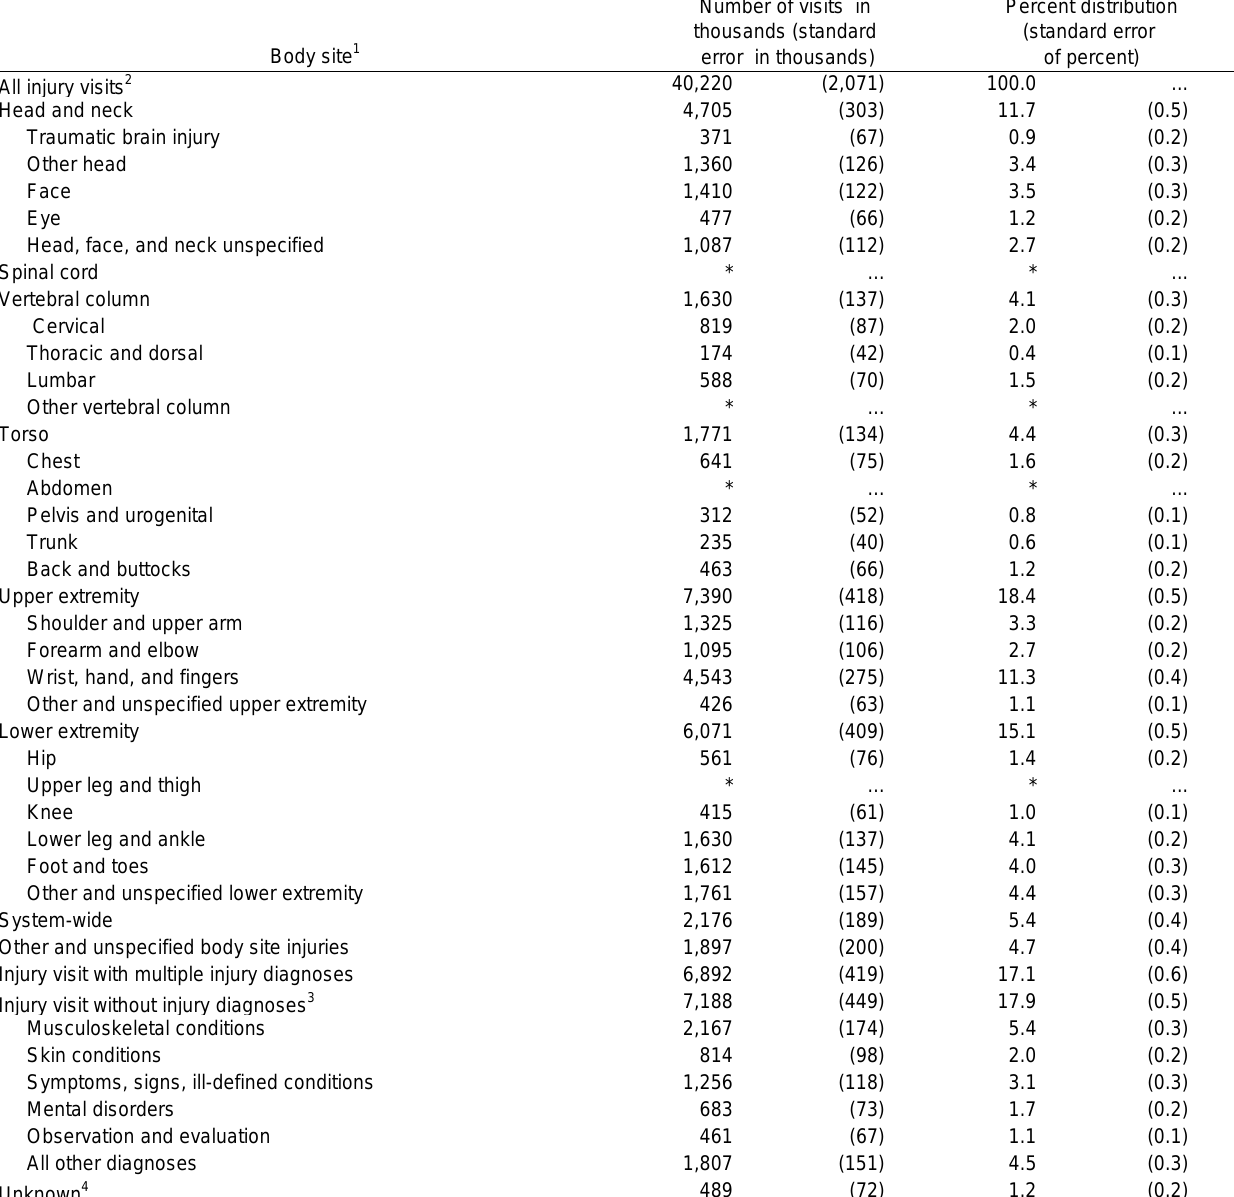
Table 16. Injury visits to emergency departments, by body site: United States,